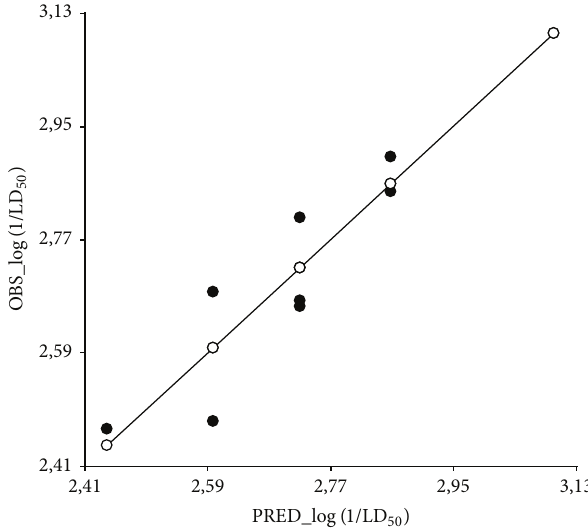
Figure 8: Multiple linear regression analysis (MLR) calculated to examine quantitative relationships between linear combinations of the dependent variable log (1/LD 50 ) and the predictor variables (structure and molecular properties). Plot of calculated versus experimental log (1/LD 50 ) of insecticidal activity of hydrocarbon compounds against cockroaches.